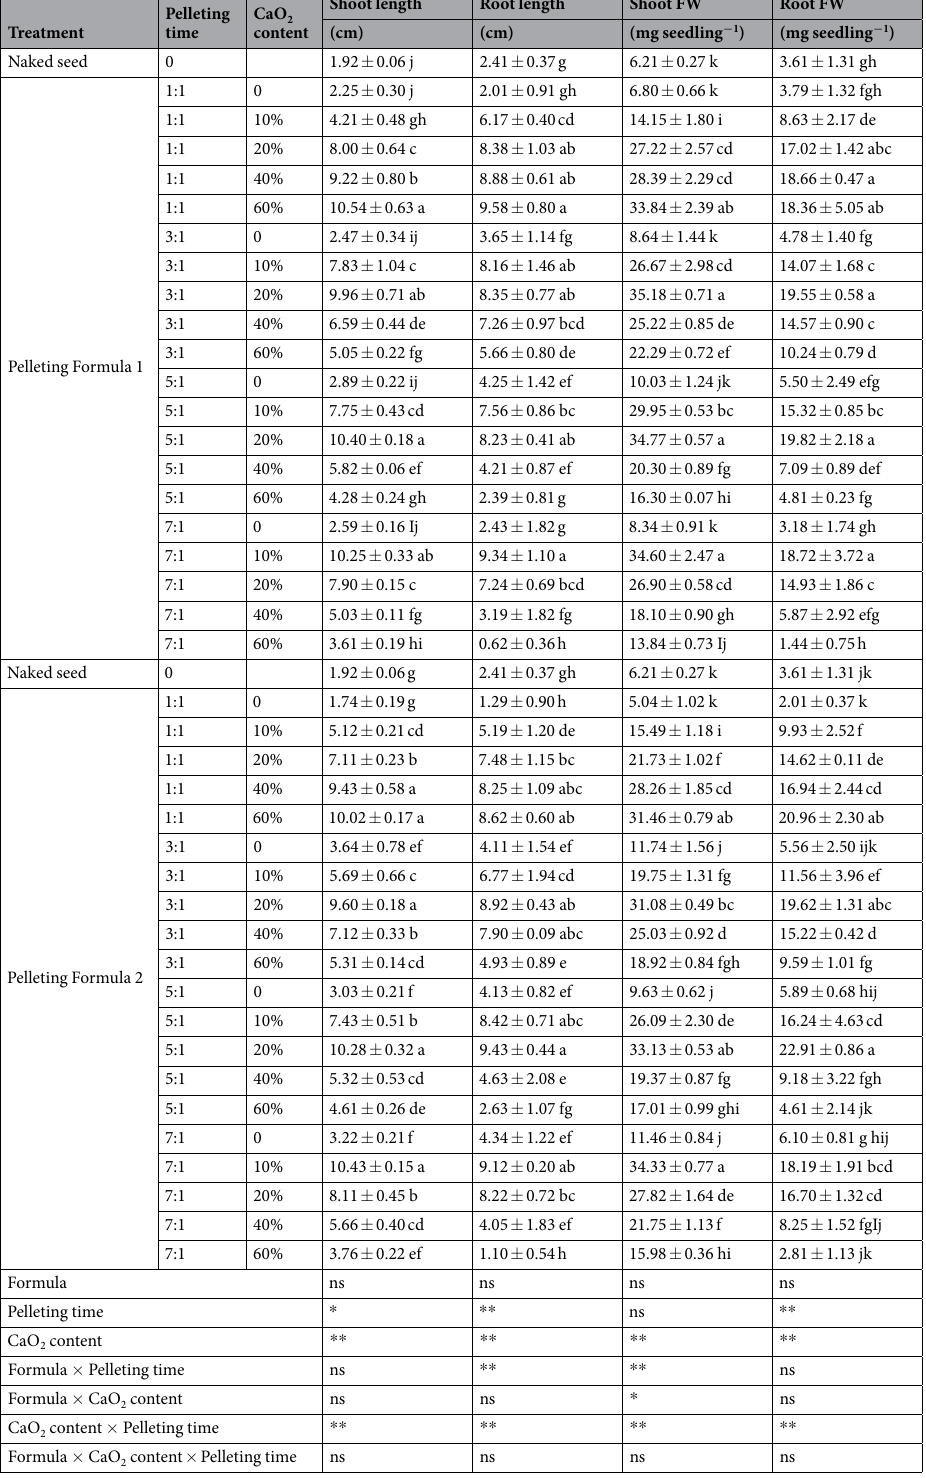
Table 3. The effect of two seed pelleting formulae with various pelleting times and CaO 2 contents on seedling growth parameters of direct-seeded rice under waterlogging conditions (1.5 cm water layer) at 8 DAS in Experiment 2. Pelleting time is the weight ratio of pelleting agent to rice seeds. Within a column under each pelleting formula, means followed by different letters are significantly different at a 0.05 probability level according to a least significant difference (LSD) test. The naked seeds were not involved in three-way ANOVA. FW: fresh weight. ** and * denote significance at the 0.01 and 0.05 probability level, respectively. ns: non-